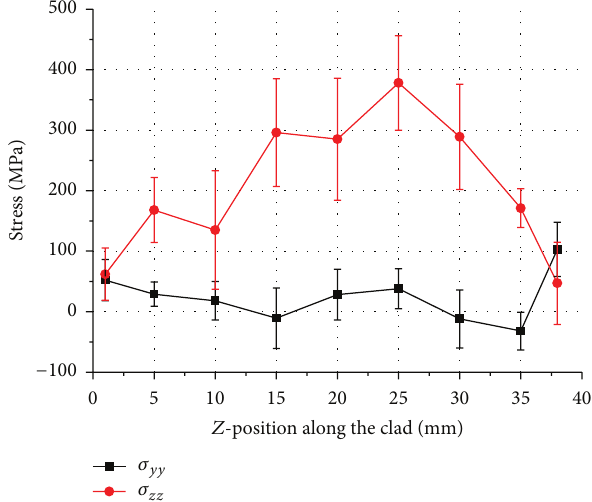
Figure 7: Stress result in sample 3, continuous wave laser deposi-